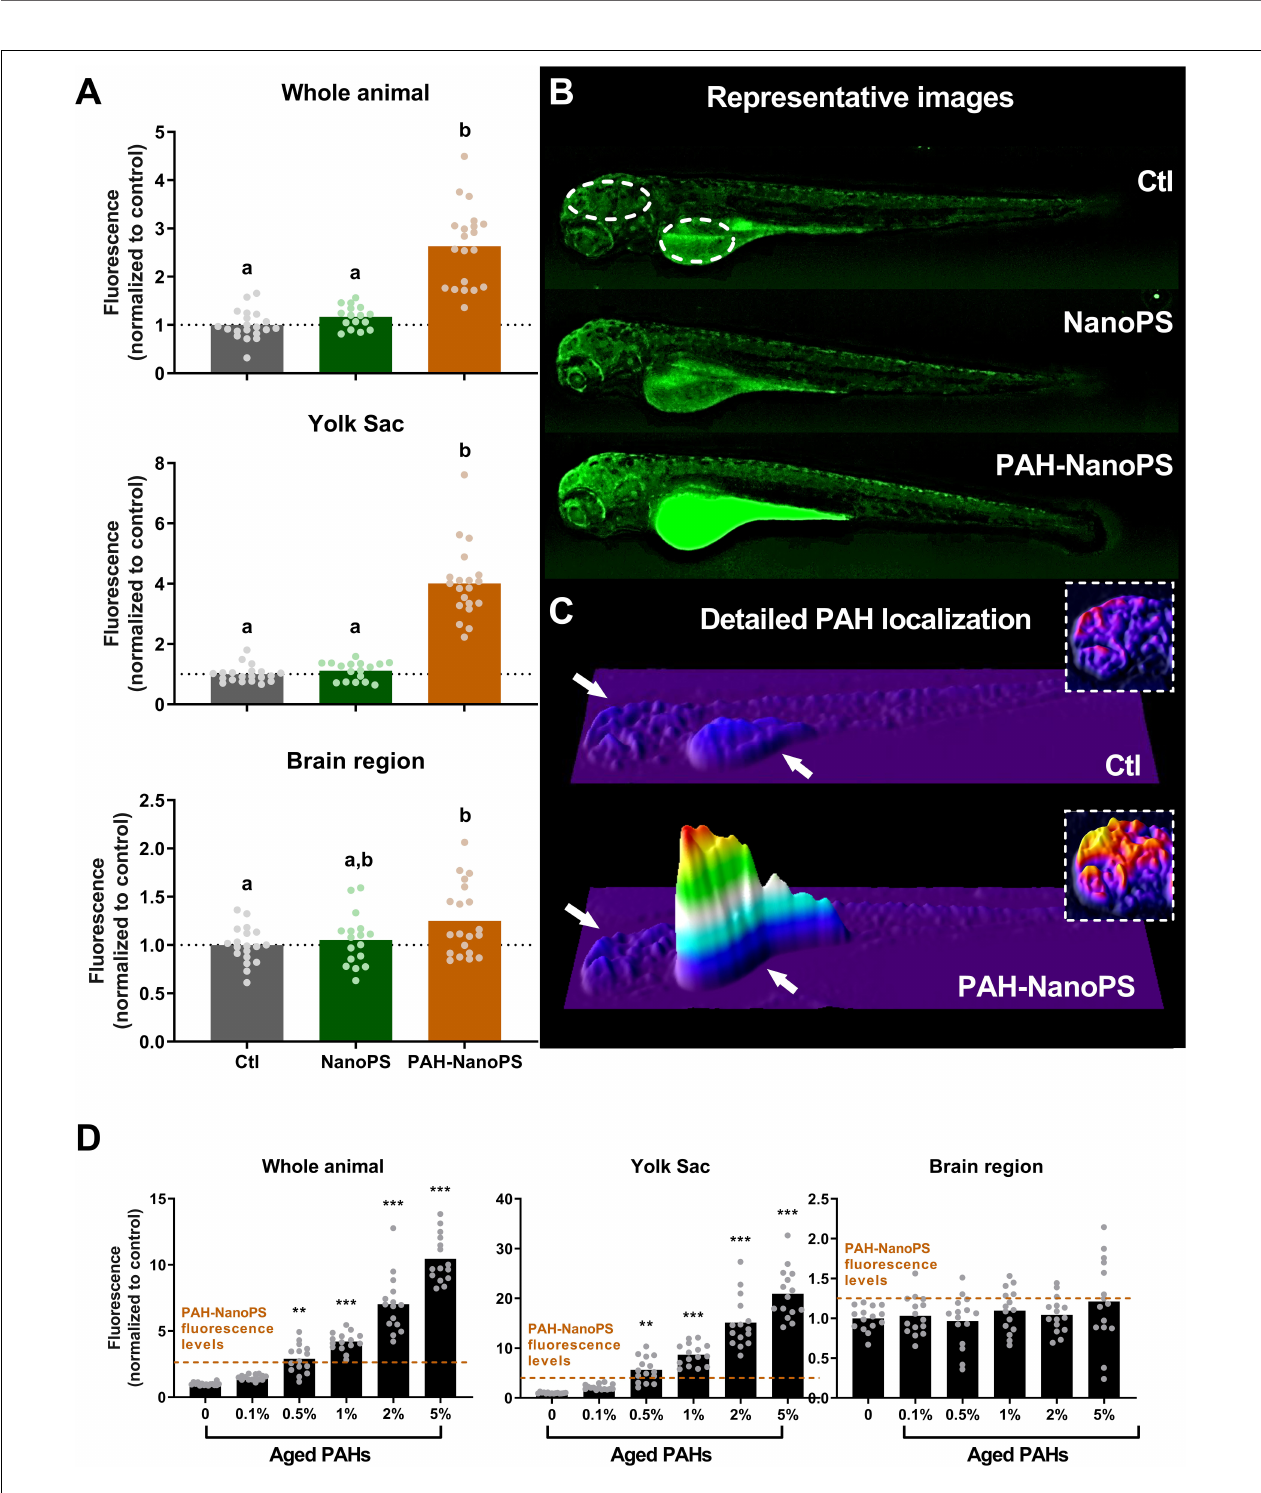
FIGURE 4 | PAH uptake estimated by green fluorescence microscopy in 96 hpf larvae. Animals were exposed at 6 h post-fertilization (hpf) to 1 ppm polystyrene nanoparticles (NanoPS) or 1 ppm polystyrene nanoparticles with PAHs sorbed to their surface (PAH-NanoPS) (see Figure 1 and section “Sorption of PAHs to the surface of NanoPS” for further details). (A) Green fluorescence was quantified in the whole animal, in the yolk sac, and in the brain region, and is shown as average and scatter plot of individual replicates ( n = 17–20). (B) Representative images are shown in the top, and the dashed circles indicate the individual areas analyzed. (C) 3D surface plot representations of the green fluorescence levels indicate that the fluorescence increase related to PAHs uptake occurs mostly in the yolk sac (arrow) and to some extent in the brain region (arrow). The insets (dashed line) represent an estimate of PAH uptake in the brain region with the color scale